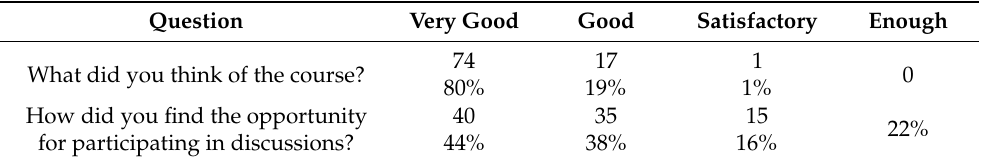
Table 2. Ranking of the online Last Aid course by the participants ( n = 92).